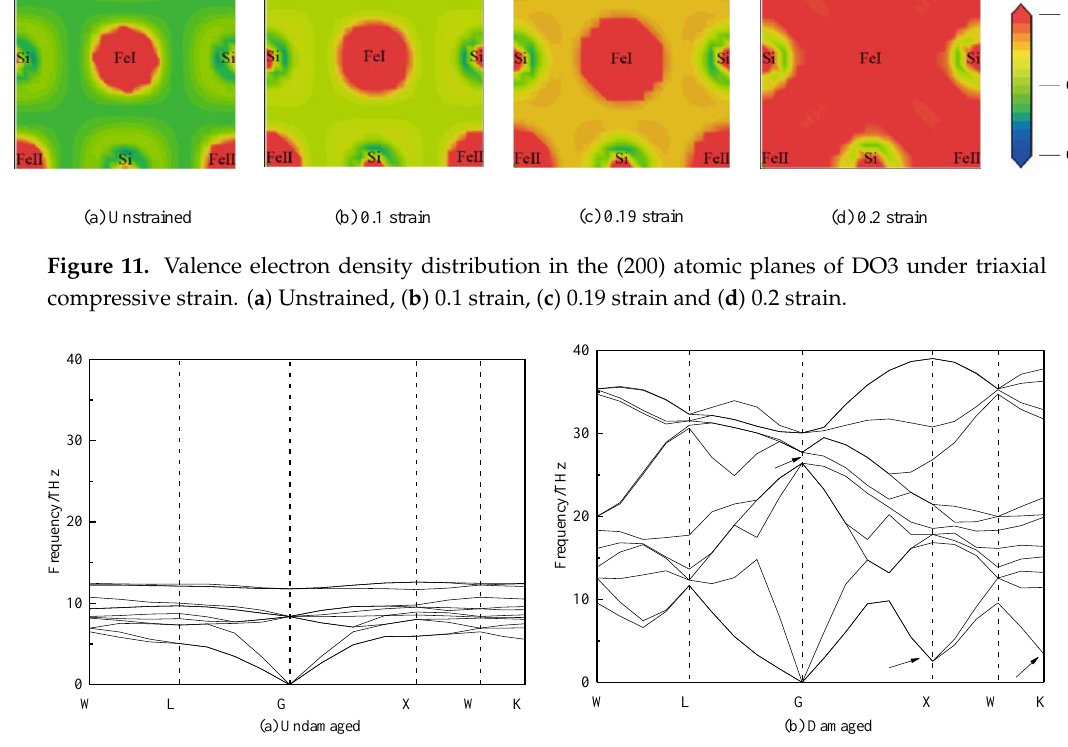
Figure 12. Calculated phonon dispersions of DO3 under triaxial compressive strain. ( a ) undamaged, and ( b ) damaged.